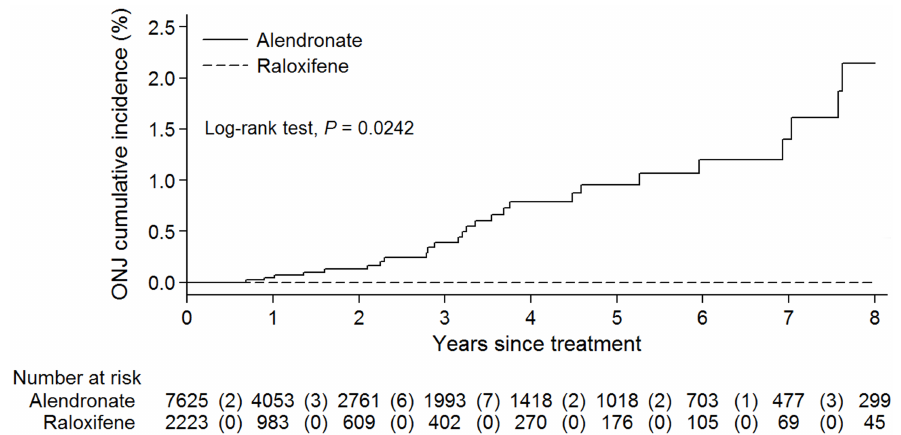
Fig 2. Time to the onset of ONJ in patients receiving alendronate or raloxifene. Numbers in parentheses indicate the number of ONJ cases at various